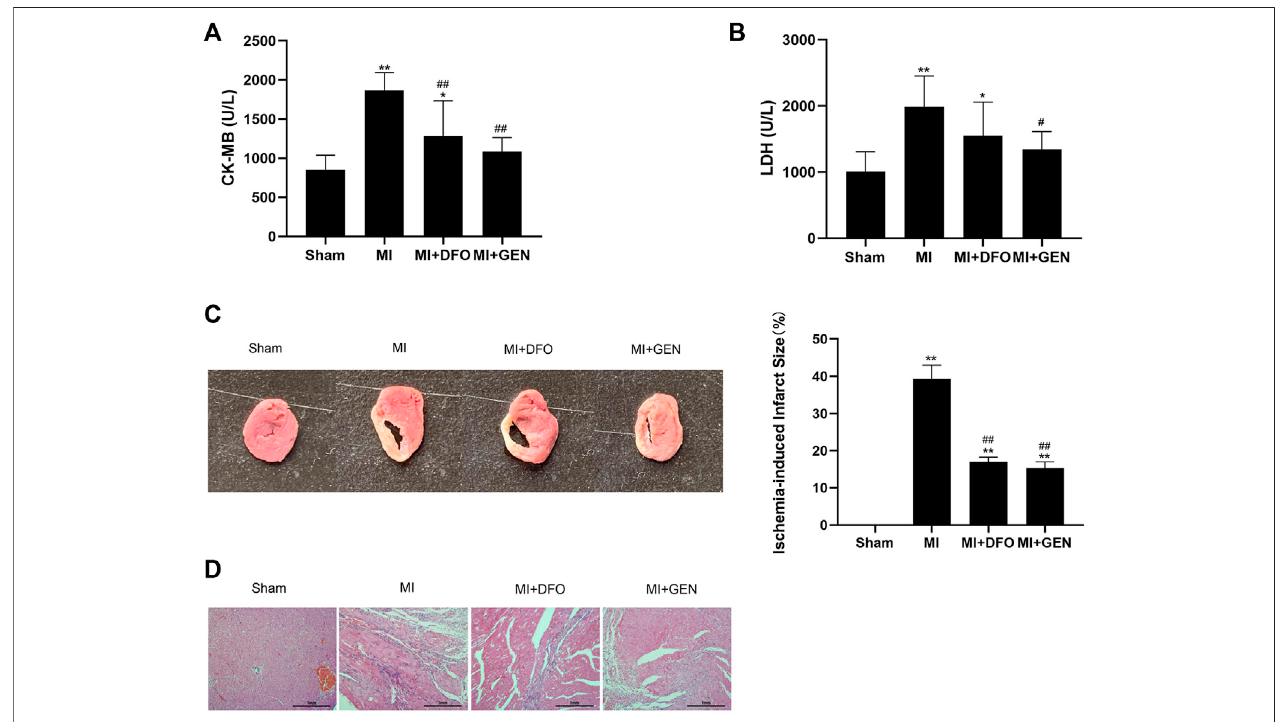
FIGURE 5 | GEN improves cardiac pathological damages in rats. (A,B) Serum CK-MB and LDH levels in rats. (C) TTC staining of heart tissues to evaluate infarct sizeinratsofeachgroup. (D) H&Estainingofrathearttissuesineachgroup.Datawereexpressedasmean±SD( n =8).* p < 0.05,** p < 0.01vs.Shamgroup; # p < 0.05, ## p < 0.01 vs. MI group. Scale bar = 1